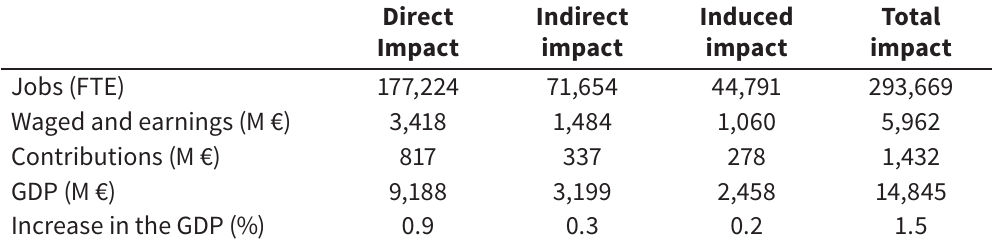
Macroeconomic impact of the elimination of the labor gap for persons with disabilities and increases in the current levels of the distinct variables, 2015 Direct Indirect Induced Impact impact impact